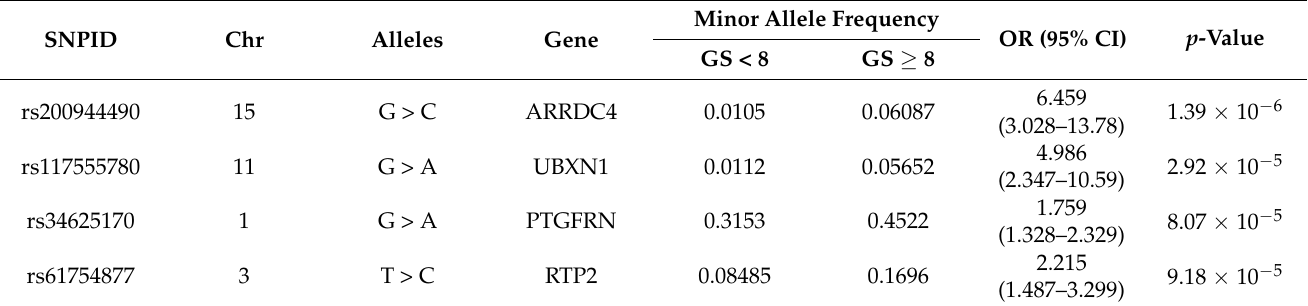
Table 2. Logistic regression analysis of exome array to predict pathological Gleason core ≥ 8 after radical prostatectomy.